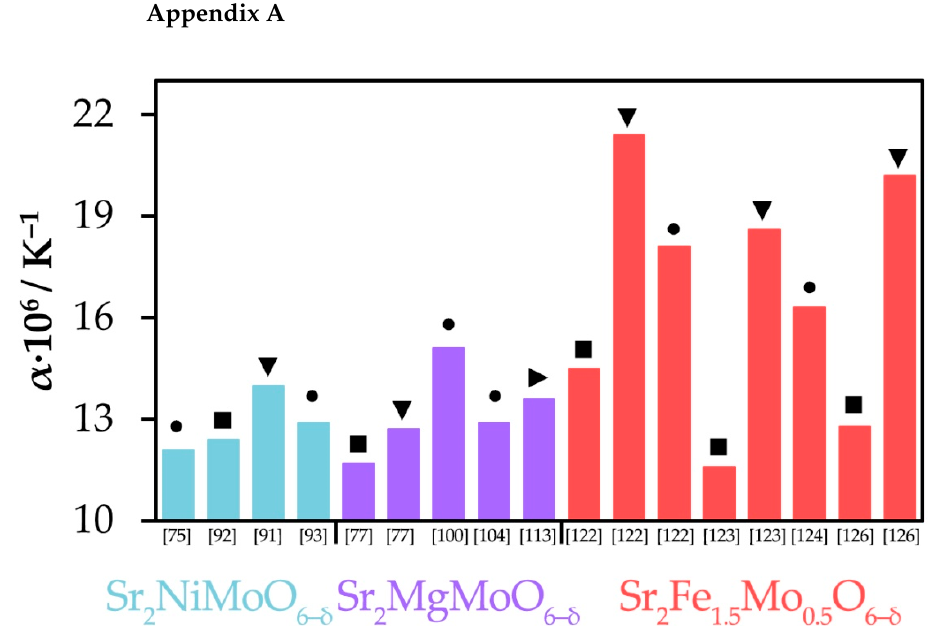
Figure A1. Thermal expansion coefficients ( α ) of Sr 2 MMoO 6– δ materials in air. Visualization of Tables 2, 4 and 7. The α values were calculated within entire- ( ● ), low- ( ■ ) and high- ( ▼ ) temperature ranges. The ► marker indicates that the data are not applicable.